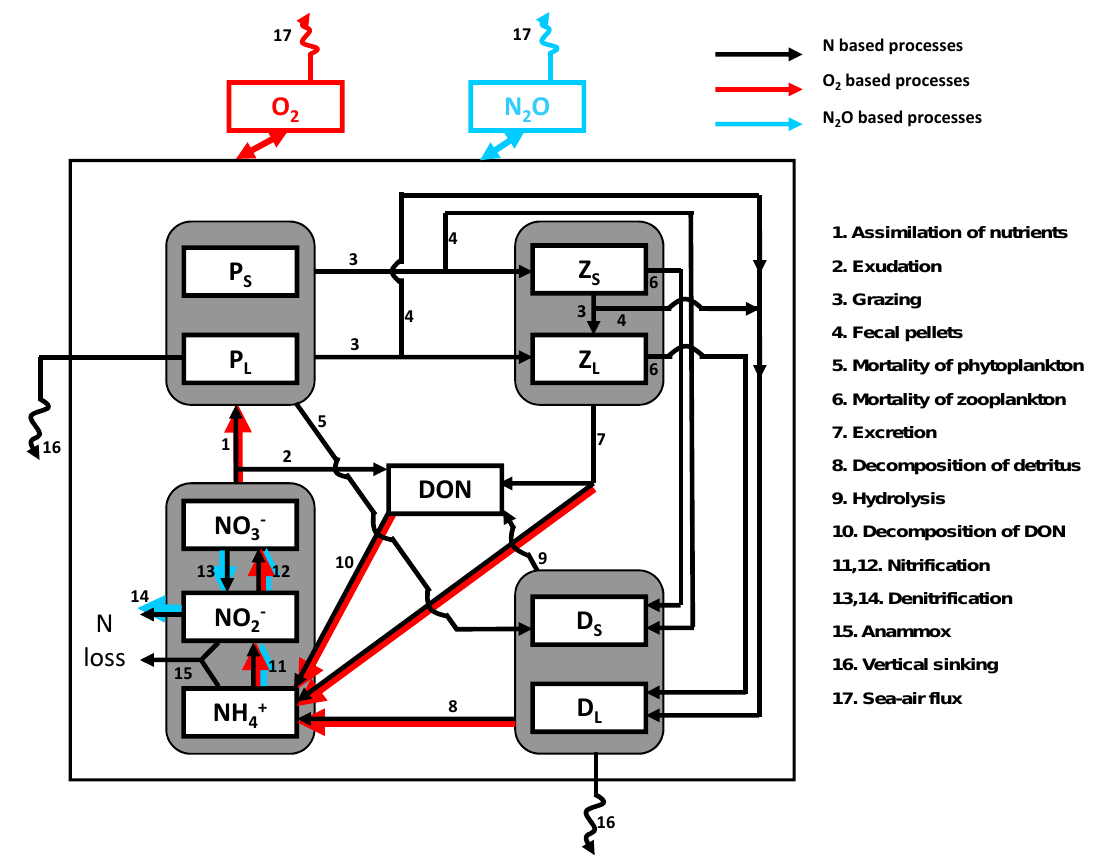
Fig. 1. Interactions between the different compartments of the BioEBUS model. Black arrows represent the nitrogen-dependent processes, red arrows the oxygen-dependent processes, and blue arrows the processes linked with N 2 O production. To simplify the representation of all interactions between variables, arrows from or to a grey rectangle act on all variables included in this grey rectangle. For example, the arrow between nutrients and phytoplankton (assimilation) is a simplification of 6 interactions: NO − NH + to P S , NH + to P L 4 4